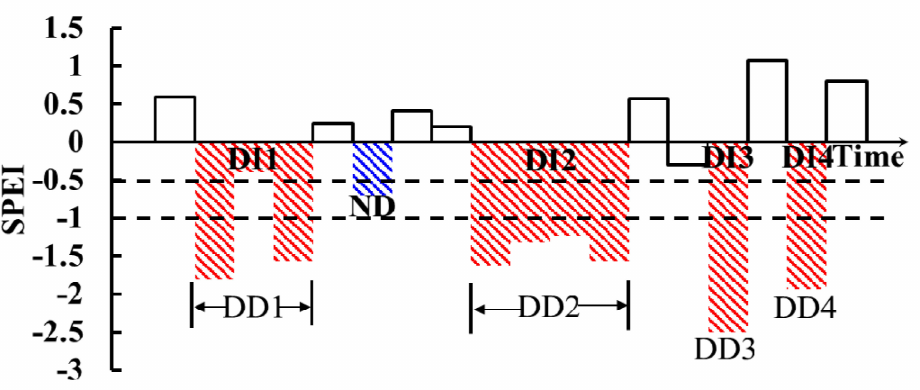
Figure 2. Identification of the drought events using the three-threshold run theory. DD = drought duration, DI = drought intensity, ND = Non drought events meeting Step 1. SPEI—Standardized Precipitation Evapotranspiration